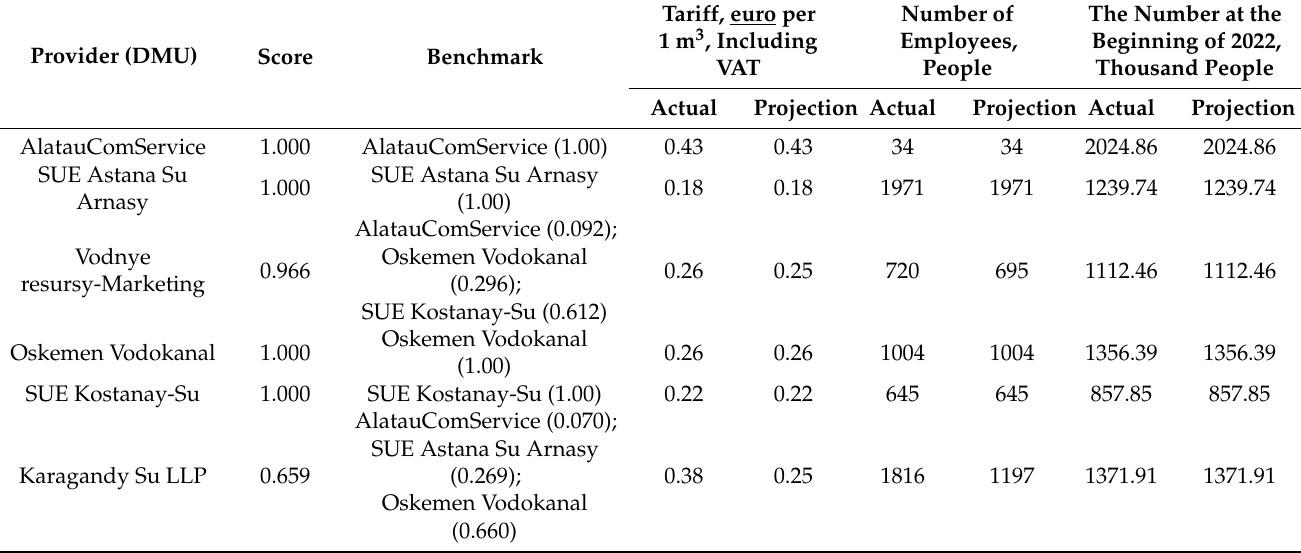
Table 10. Envelopment Model Input-oriented results for 2022’s water supply and sewage